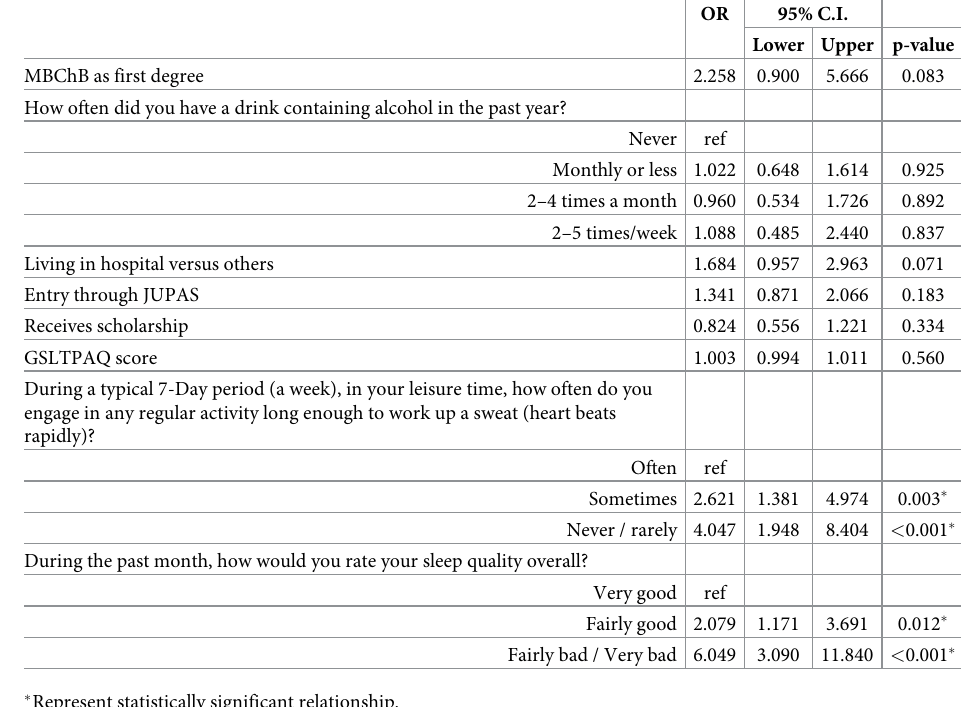
Table 4. Logistic regression model for medical students’ burnout and their demographics/lifestyle